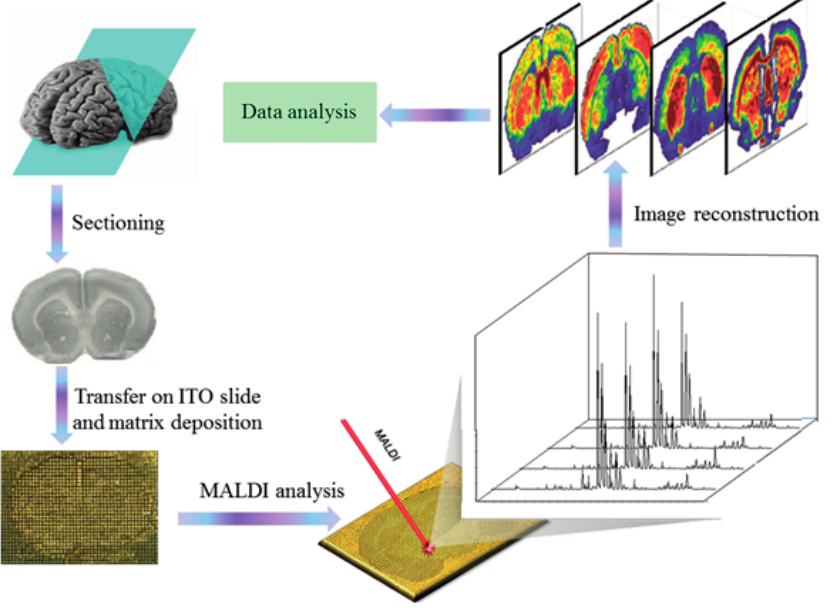
Figure 3. Schematic representation of the MALDI-IMS work